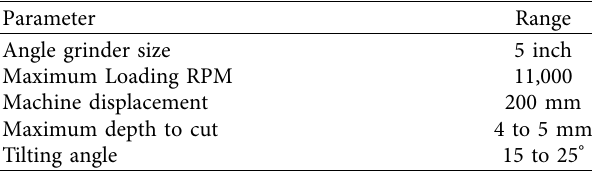
Table 2: Specification of performance evaluation machine Parameter